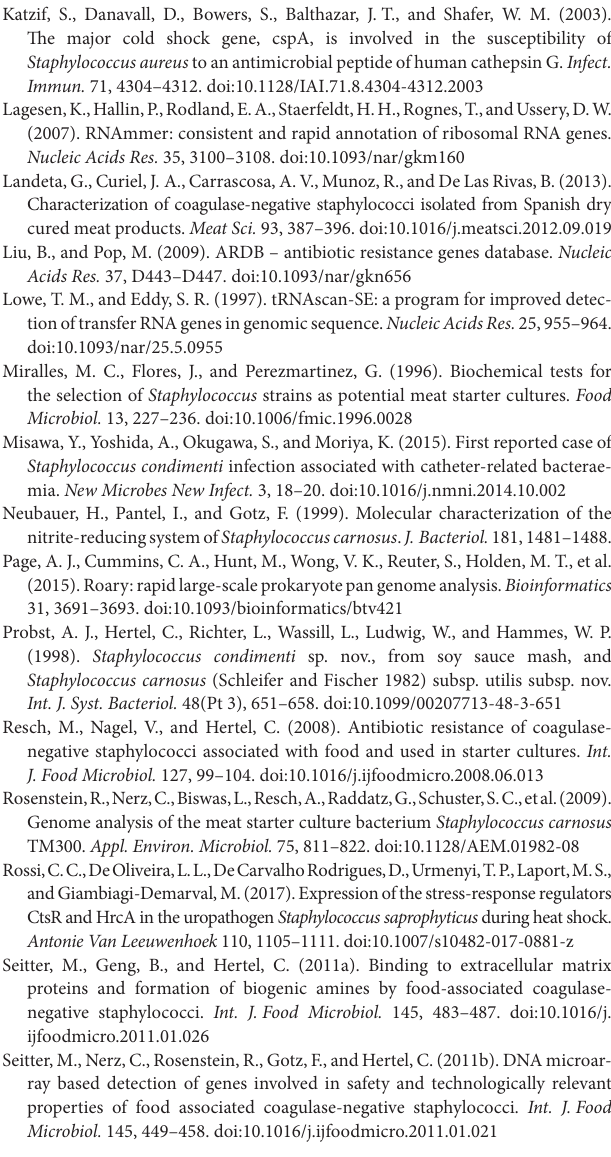
FIGURe S1 | Biochemical characteristics of Staphylococcus condimenti DSM 11674. (a) Nitrate reductase activity of S. condimenti DSM 11674. (B) Catalase